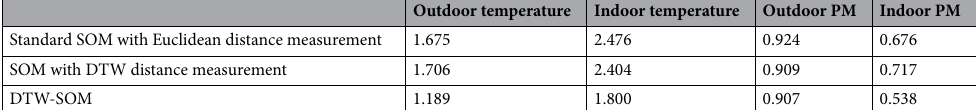
Table 3. Quantization errors from applying the three SOM algorithms, each with a 5 × 5 output space (25 neurons), separately to each of the four residential sensor